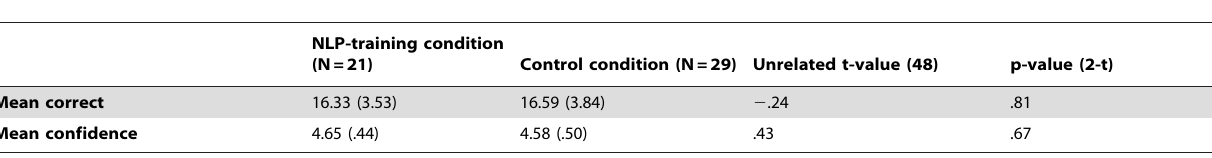
Table 2. Number of correct judgements (MCE=16) in Truth and Lie